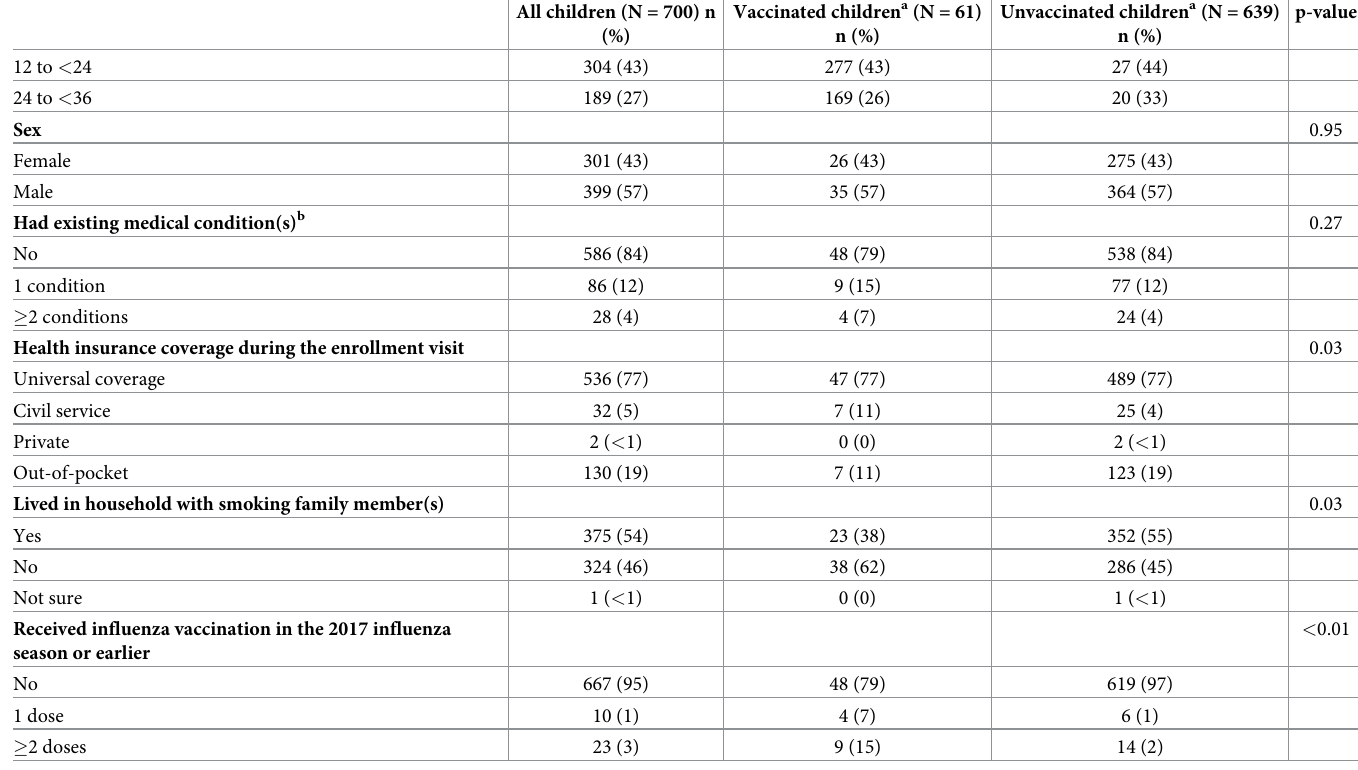
most trusted source regarding influenza vaccine for children was the child’s doctor (80%; Fig 2 ). Attitude/perception toward influenza illness and influenza vaccine Among 541 respondents who knew about influenza illness, similar proportions of vaccinated and unvaccinated children had caregivers who were worried about the child getting sick with influenza (Table 2). Their perceived likelihood of the enrolled children being harmed by sea- sonal influenza virus infection was also not significantly different. Of 469 respondents who knew of influenza vaccine, most were aware of the MOPH’s rec- ommendation for influenza vaccination in children, and this differed by vaccination status (95% in the vaccinated group vs. 79% in the unvaccinated group; p-value = 0.02). More care- givers of vaccinated children strongly agreed with the recommendation compared to those of unvaccinated children (76% vs. 54%; p-value < 0.01). Both groups of caregivers perceived the vaccine as very effective or somewhat effective. However, attitude/perception toward influenza vaccine safety among young children was significantly different. Specifically, 44% of the care- givers of vaccinated children perceived the vaccine as completely safe compared to 26% of the caregivers of unvaccinated children (p-value 0.02). Lastly, intention to have the enrolled chil- dren vaccinated was similar in both groups of